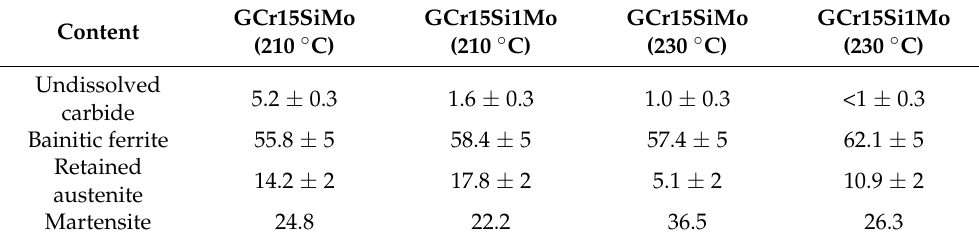
Figure 5. GCr15Si1Mo steels austempered at 210 °C for 8 h: ( a ) metallographic microstructure; ( b ) binary image. Table 2. The content of each phase in the steels austempered at different temperatures (vol.%).